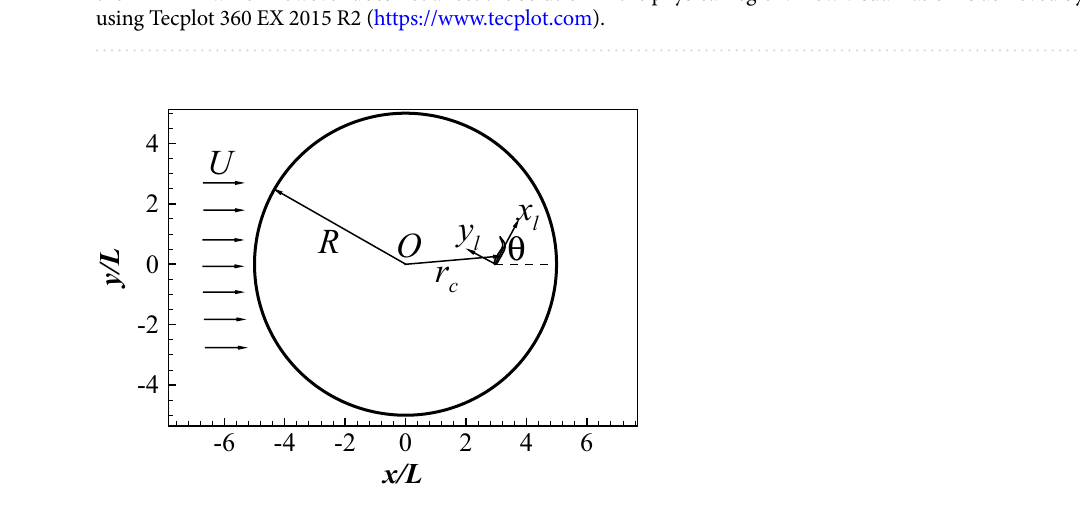
Figure 11. The confined domain of the rheotaxis